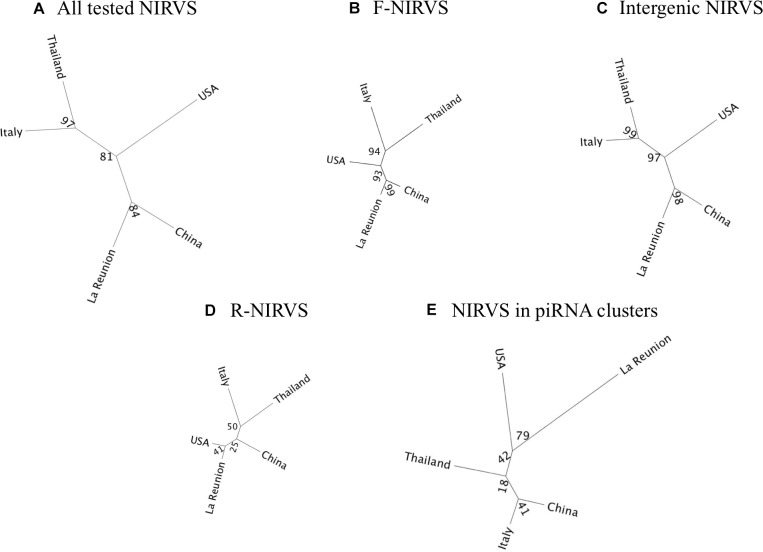
Phylogeographic distribution of NIRVS. Genetic relationships among five mosquito populations shown by a Neighbor-joining trees based on shared-allele distance using data from all 13 genotyped NIRVS (A), only F-NIRVS (B), NIRVS mapping in intergenic regions (C), only R-NIRVS (D) and NIRVS mapping in piRNA clusters (E). Bootstrap values are shown at the corresponding nodes.